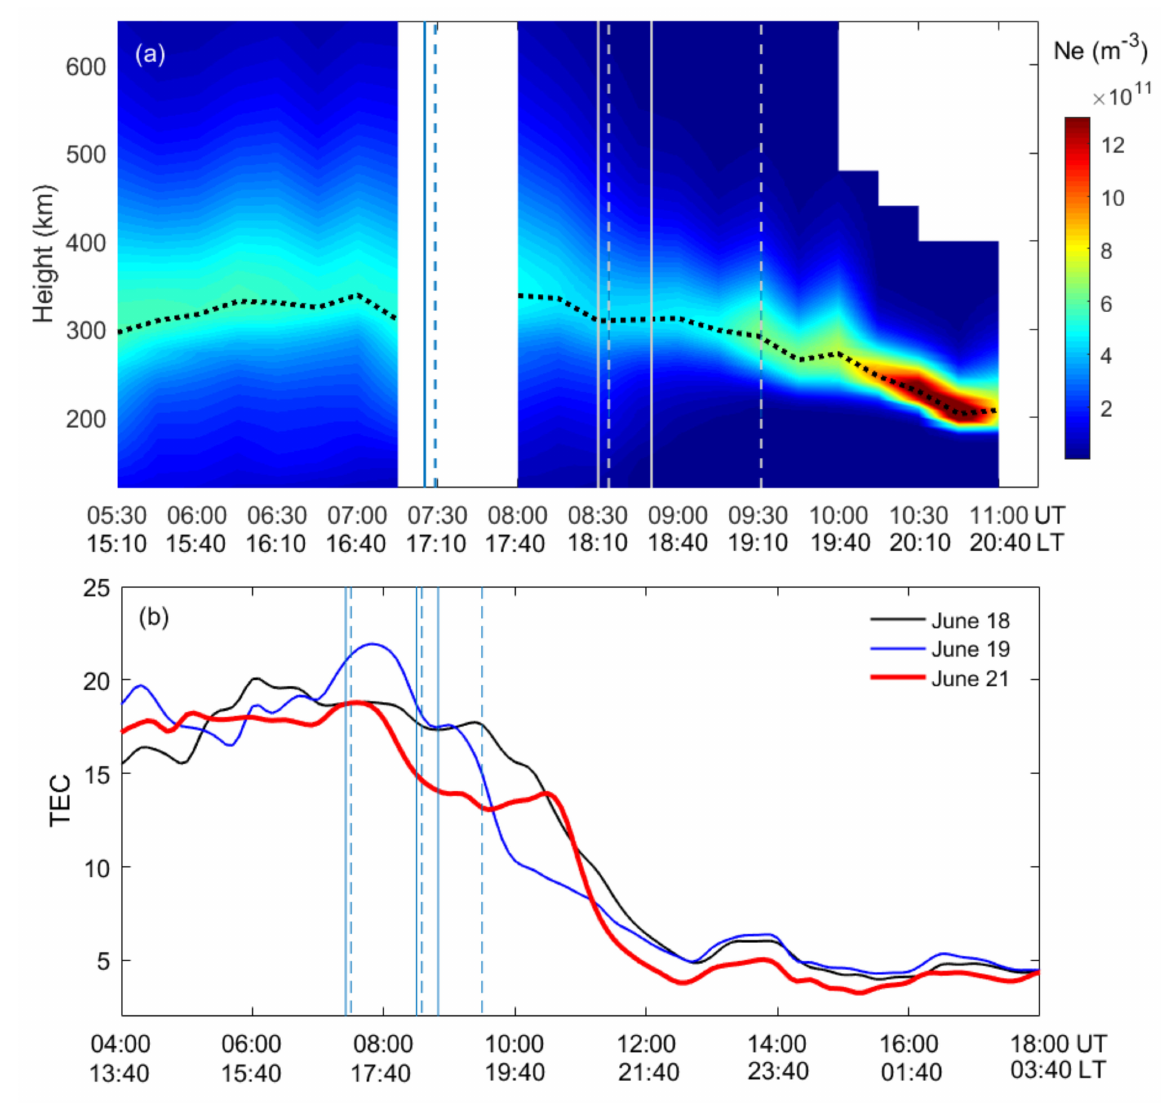
Figure 4. The plasma density profiles and total electron density content (TEC) recorded over Guam. ( a ) The plasma density profile derived from the ionogram recorded by Guam ionosonde on the solar eclipse day. The black dotted line represents the evolution of h mF2. ( b ) The comparison of TEC on the solar eclipse day (red line) and the reference